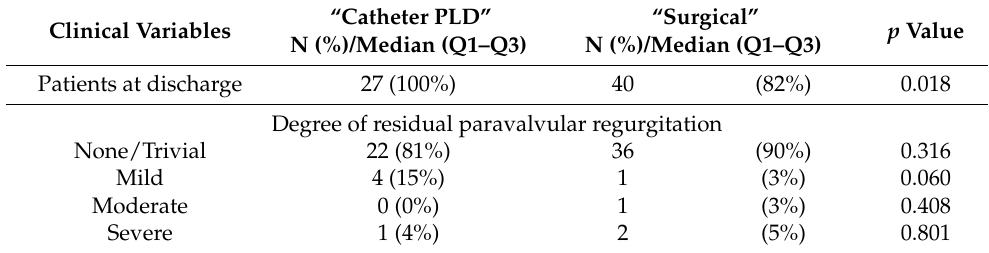
Table 3. Results of mitral PVL treatment at